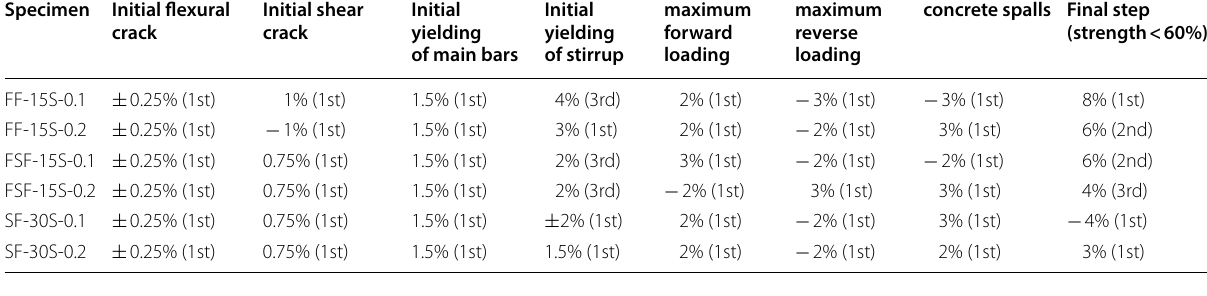
Table 6 Performance points of each specimen under cyclic loading.